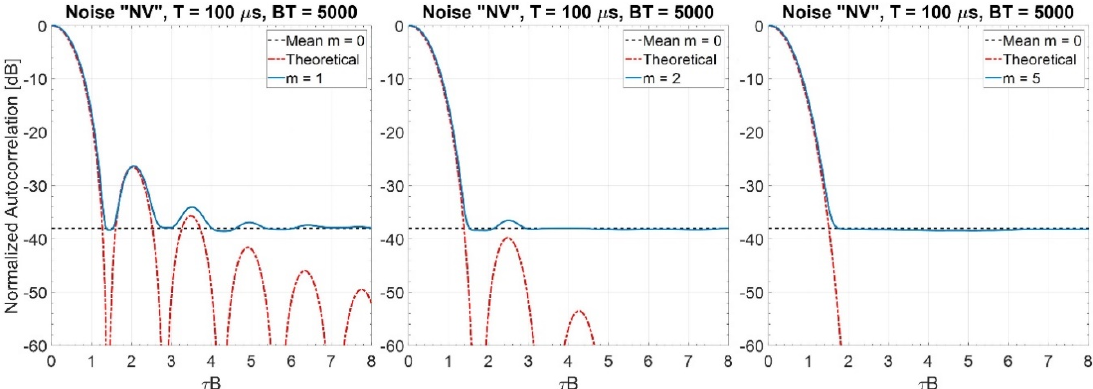
Figure 7. Normalized autocorrelation of “NV” noise waveforms for BT = 5000 (values are estimated on 1000 trials), m = 1, 2, and 5. Table 3. Normalized bandwidth ( − 3, − 6, − 10, and − 20 dB) of the spectrum for “SC” waveforms. “SC”